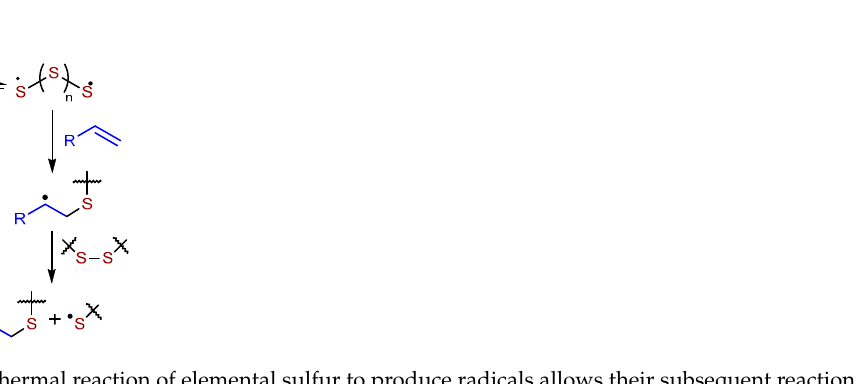
Scheme 2. Reaction of terpenoids such as geraniol and farnesol with sulfur leads to HSMs GerS x and FarS x comprising several microstructures resulting from a combination of inverse vulcanization and intramolecular cyclization reactions.